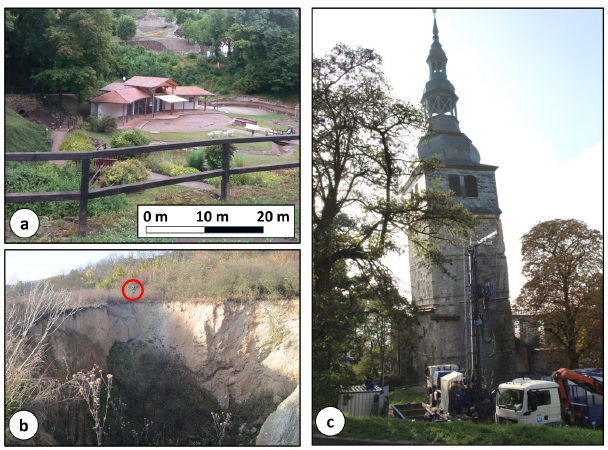
Figure 3. Subrosion signatures at the surface in Bad Frankenhausen and the surrounding area. (a) The oldest sinkhole of the region, called “Quellgrund”, is located in the medieval city center of Bad Frankenhausen and used today as recreation area. (b) One of the most recent sinkholes is found directly beside the “Äbtissinnen Grube” (red circle marks a person standing at the sinkhole margin). (c) The most famous subrosion phenomenon is the leaning church tower of Bad Frankenhausen (height of 56m); note borehole in fore-